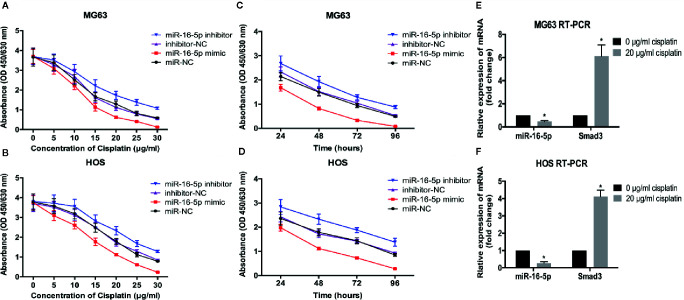
Therapeutic efficacy of cisplatin in osteosarcoma cells was enhanced by over-expression of miR-16-5p. the cell viabilities of MG63 and HOS cells treated with varying concentrations of cisplatin (A, B) for 48 h and with 20 μg/ml for different times (C, D). (E, F) miR-16-5p and Smad3 were detected by real-time PCR (RT-PCR) in cells incubated with or without 20 μg/ml cisplatin. *indicates p < 0.05.